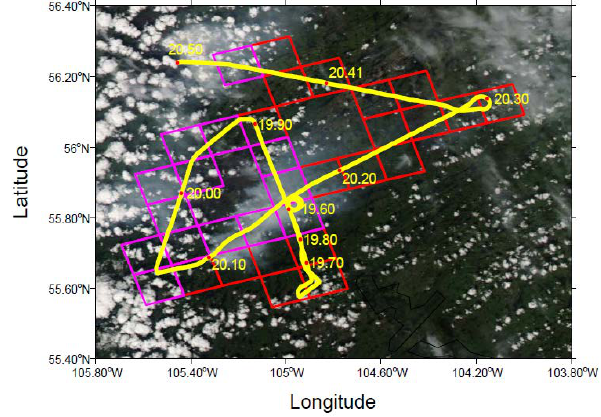
Figure 4. Aqua MODIS RGB image for the overpass at 19.58 UT on 02 July 2008, with overlay Fig. 4. Aqua MODIS RGB image for the overpass at 19.58UT on 2 of locations of the P-3 flight track (yellow) and the MODIS 10-km resolution aerosol retrieval July 2008, with overlay of locations of the P-3 flight track (yellow) grid cells (red for a retrieval with the MODIS operational algorithm, and magenta for a retrieval and the MODIS 10km resolution aerosol retrieval grid cells (red for only for the cloud mask or the cloud and NDVI masks off). a retrieval with the MODIS operational algorithm, and magenta for a retrieval only for the cloud mask or the cloud and NDVI masks